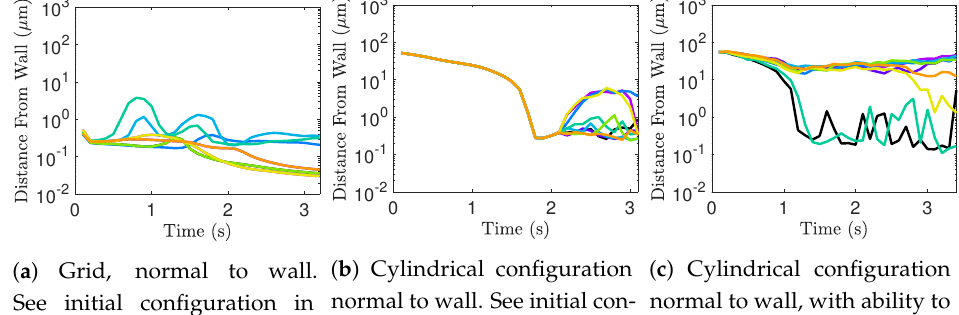
figuration in Figure 6f and Sup- plemental Materials Movie S12.